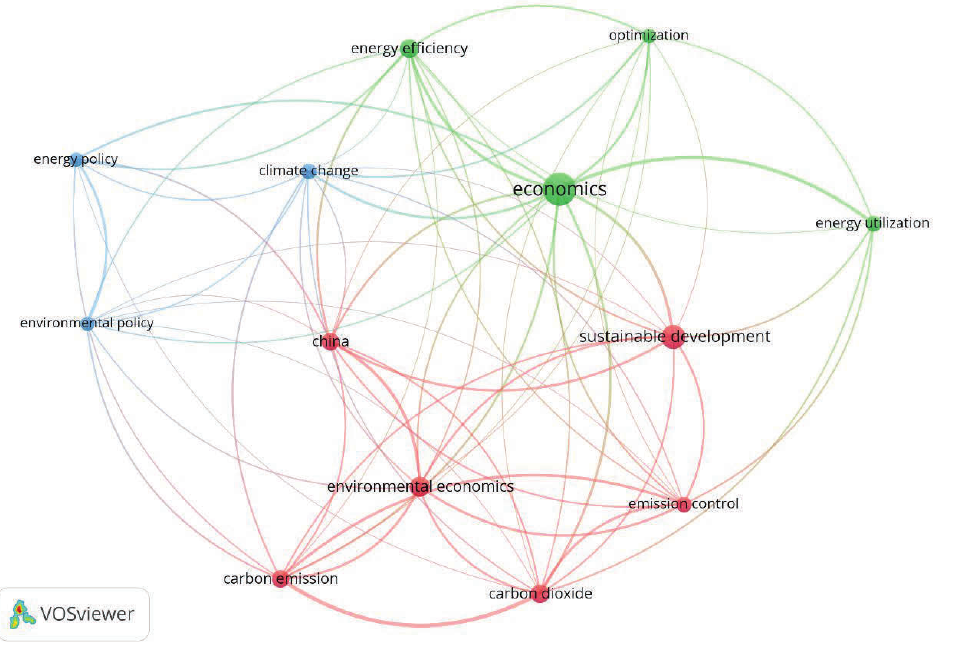
Fig. 6. Keyword co-occurrence for 2 nd query with a threshold of at least 10